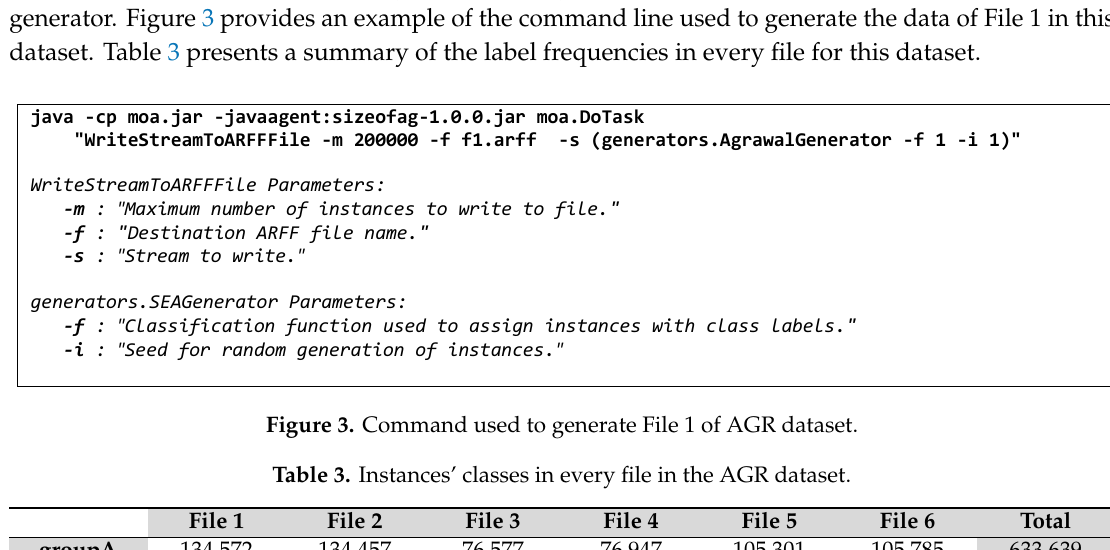
Table 3. Instances’ classes in every file in the AGR dataset.